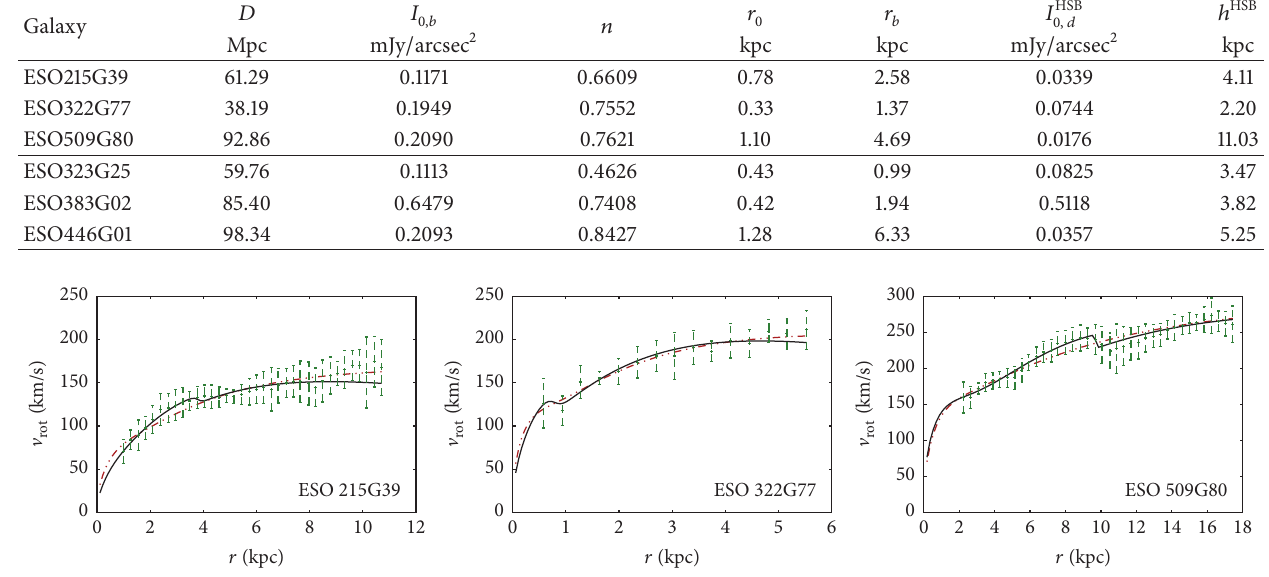
Table 1: The distances ( 𝐷 ) and the photometric parameters of the 6 HSB galaxy sample as determined by the fit with available photometric data [37]. Bulge parameters: the central surface brightness ( 𝐼 0,𝑏 ), the shape parameter ( 𝑛 ), the characteristic radius ( 𝑟 0 ), and radius of the bulge ( 𝑟 𝑏 ). Disk parameters: central surface brightness ( 𝐼 HSB 0,𝑑 ) and length scale ( ℎ HSB ) of the disk.